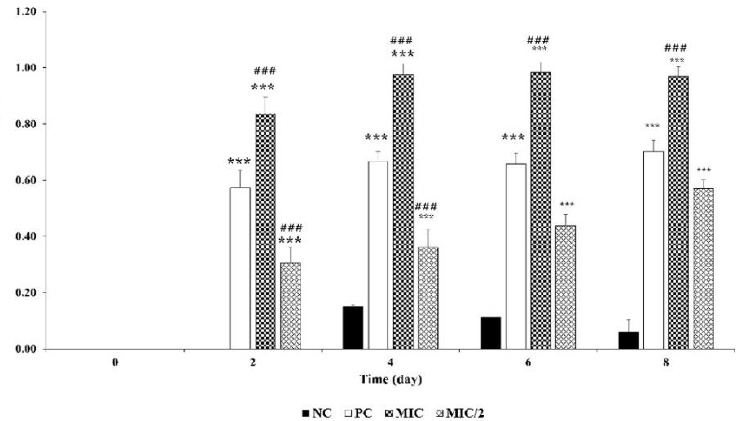
Figure 3. Effect of R. aquatilis aqueous extracts on MDA level of M. aeruginosa cells. Each value is the mean ± SD of three replicates. *** p < 0.001 indicate significant differences compared to the untreated culture and ### p < 0.001 indicate significant differences compared to the positive control. T0 < LOD. CAT activity in the control remained stable below 1 U∙mg −1 proteins, while SOD ac- tivity was detected only on the first day of the experiment (0.6 U∙mg −1 proteins) (Figure 4).